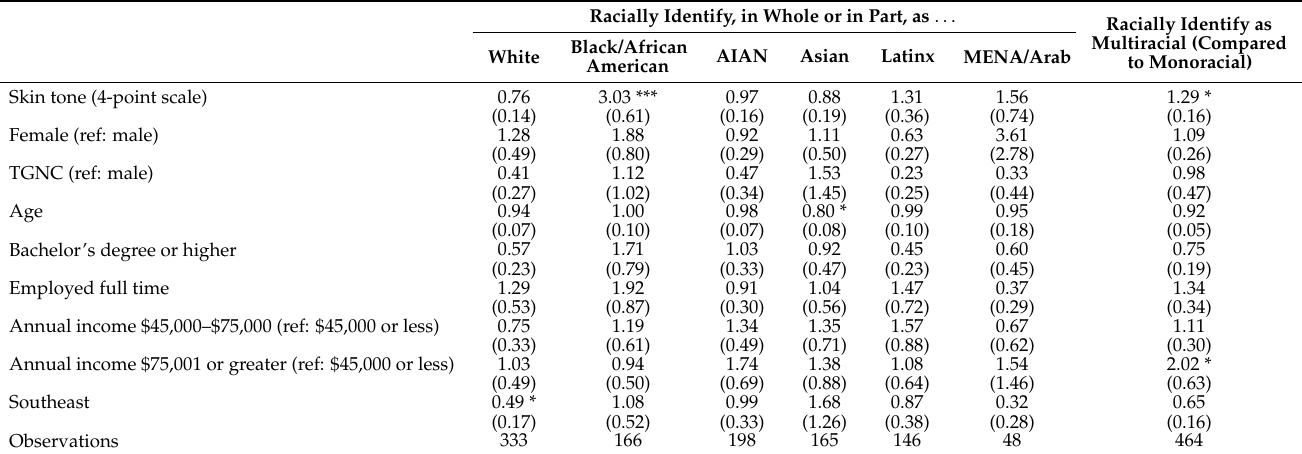
Multiracial (Compared to Monoracial)White